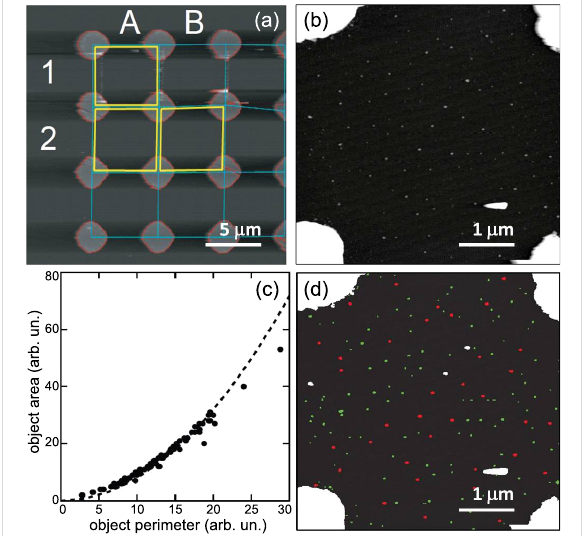
Figure 4: (a) The automation algorithm identifies the experimental cells from the macroscopic reference grid, (b) then zooms in. Each object over a given height threshold is classified according to its dimensions (c) (the dotted line indicates the area:perimeter ratio of a circle). The result of this classification is given in (d): larger noncircular features are classified as contaminations or QD clumps (white), whereas single quantum dots are given a red (larger) or green (smaller) colouration (indicating their position in the QD size distribu-